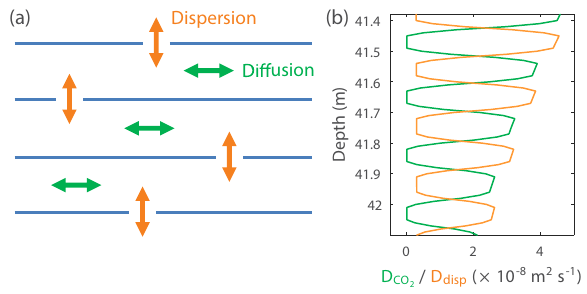
Figure 7. Diffusion and dispersion in layered firn. (a) Schematic of conceptual model where the horizontal blue lines depict dense firn strata with limited vertical connectivity. (b) Layering as imple- mented in the firn air diffusion model; the zoom is on four annual layers just above the lock-in